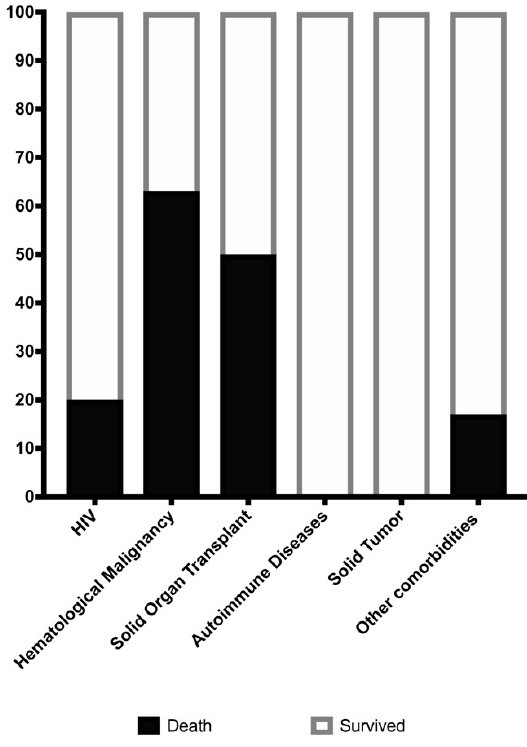
Figure 3. Cryptococcal infection case fatality rate for each examined comorbidity.